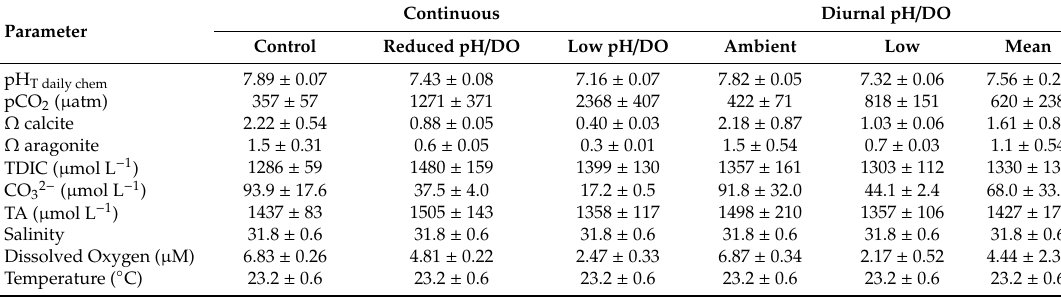
Table 5. Mean ( ± standard deviation) pH, pCO 2 , saturation states of calcite and aragonite, total dissolved inorganic carbon (TDIC), carbonate, total alkalinity (TA), salinity, dissolved oxygen, and temperature for the Menidia beryllina four treatment diurnal acidification and hypoxia experiments.